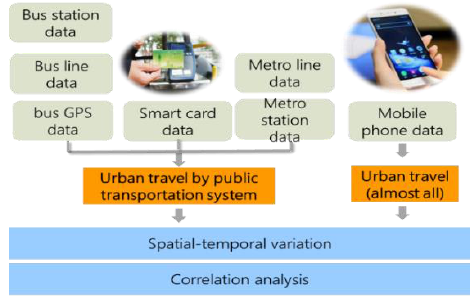
Figure 2. Workflow of